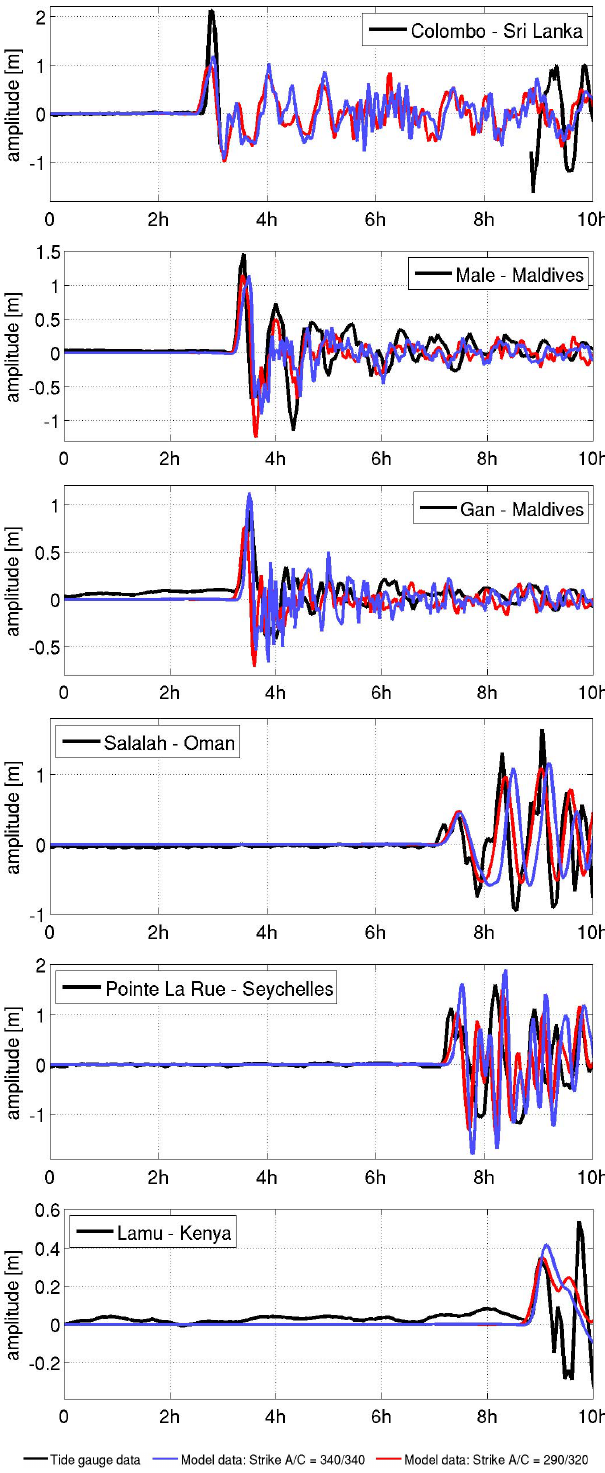
Fig. 12. Tide gauge (TG) records and corresponding model results in locations displayed in Fig.